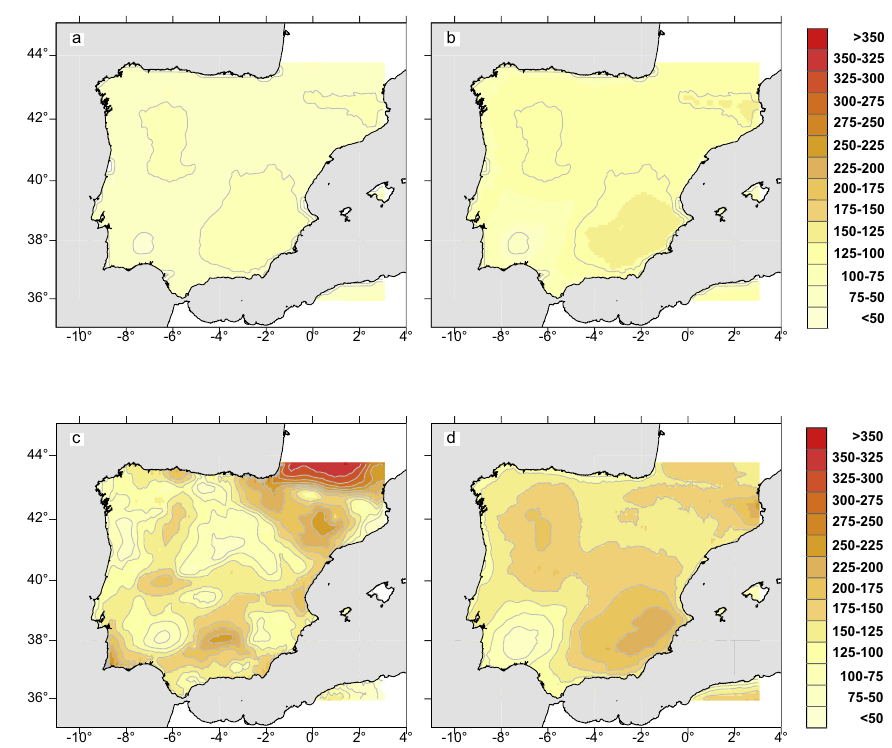
Fig. 8 Differences in temperature distribution between thermal modeling based on Bayesian geophysical– petrological inversion of surface waves, surface heat flux, elevation, and geoid anomalies (Fullea et al. 2021), and on geoid and elevation inversion integrated with 3D inversion gravity modeling (Torne et al. 2015), at 5 km crustal depth ( a ), at 10 km ( b ), at 20 km ( c ) and at Moho depth ( d